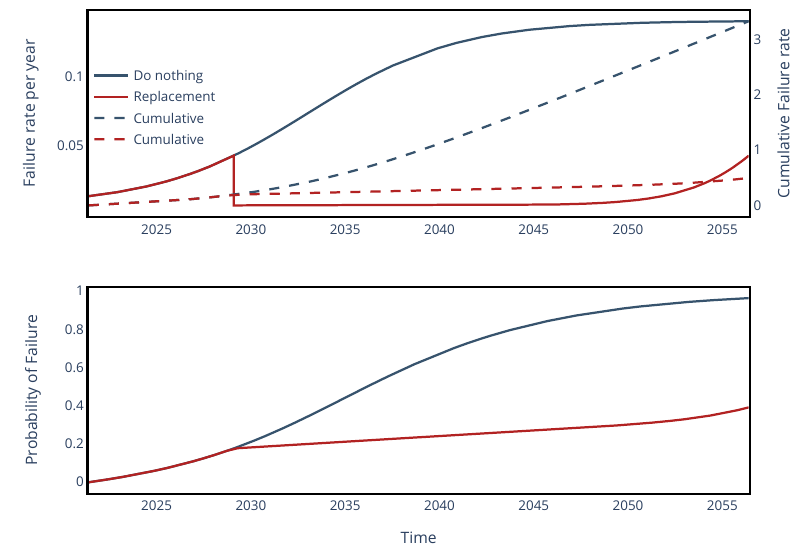
Figure 15. Influence of the optimal TR_1 replacement on their failure rate and